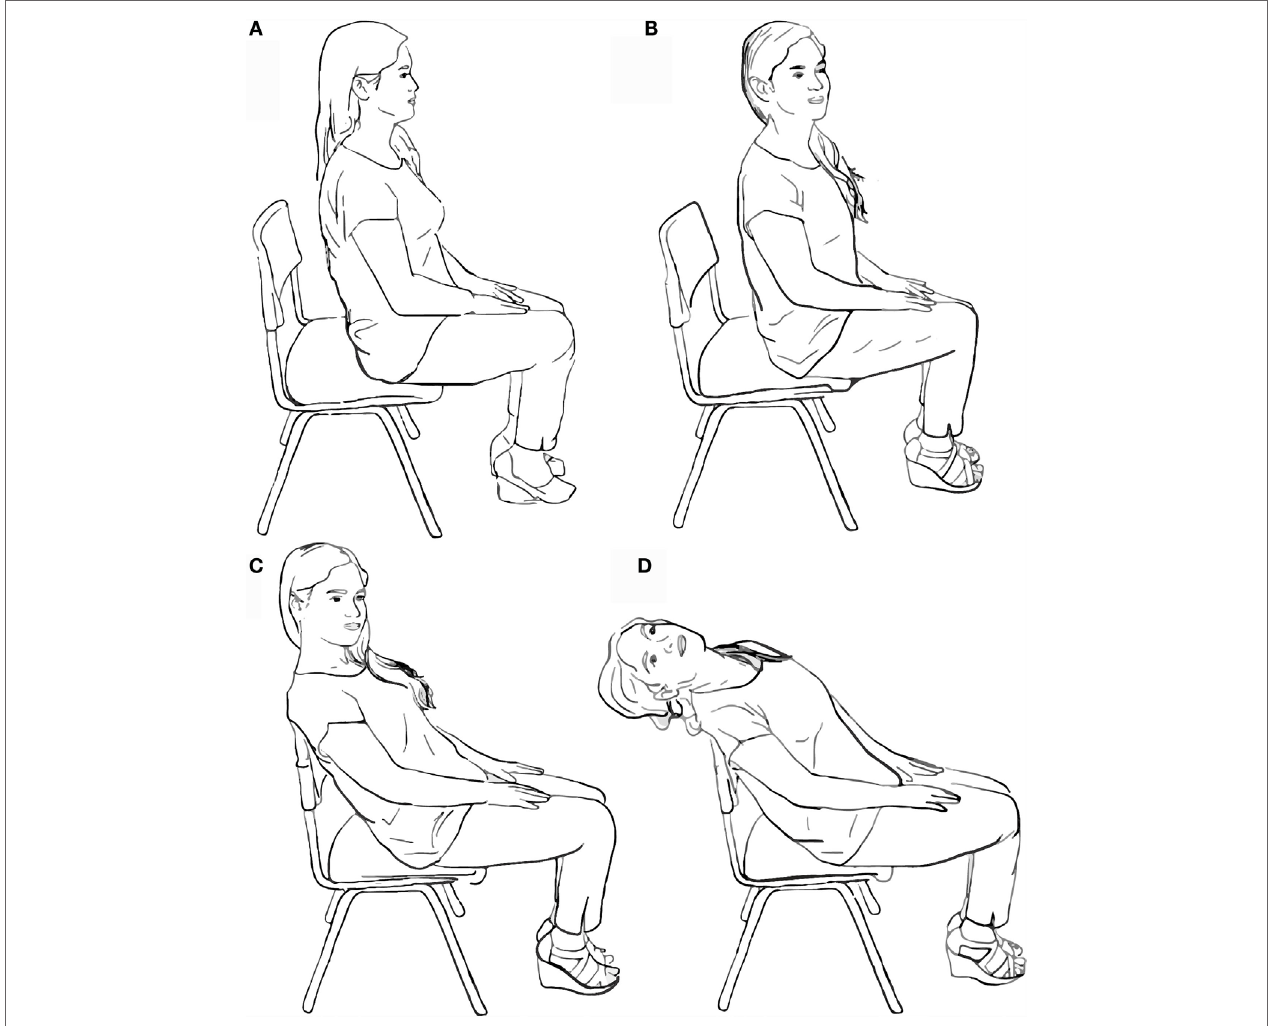
FigUre 4 | Performing the mini Dix–hallpike maneuver . (a) First, the patient is asked to sit on the front edge of a backed chair. (B) The patient’s head is then turned 45° toward the side being examined. (c) The patient is pulled backward into a resting position against the back of the chair. (D) The patient’s head is then pulled backward into a hanging